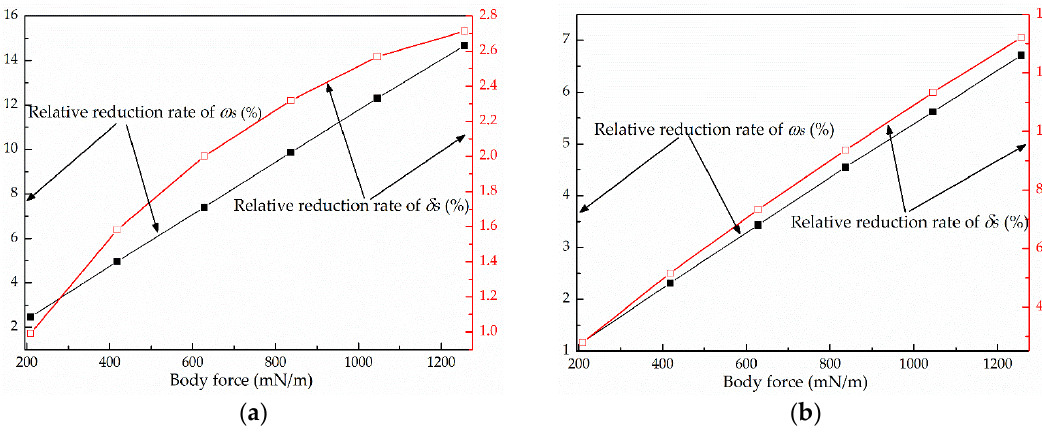
Figure 10. Influences of plasma actuations on the high-speed compressor cascade total pressure loss and blockage coefficients, with plasma actuators inducing different body forces. ( a ) Suction surface plasma actuation; ( b ) Endwall plasma actuation.